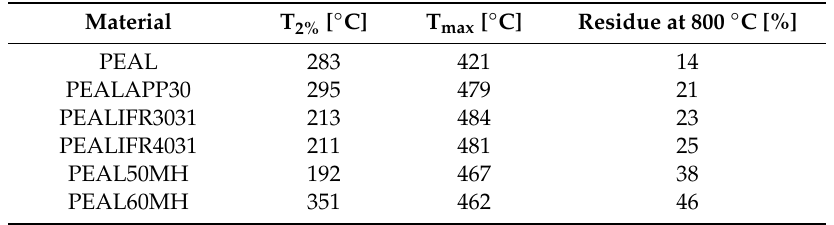
Table 3. T 2% , T max and residue at 800 ◦ C of PEALAPP30, PEALIFR3031, PEALIFR4031, PEAL50MH and PEAL60MH in oxidative atmosphere. Also, the values of PEAL are